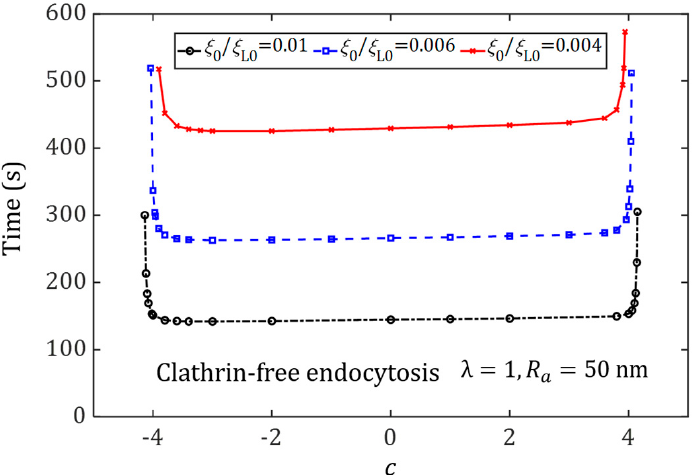
Figure 6. Wrapping time as a function of the degree of non-uniformity of ligand distribution, c , at different initial receptor density situations ξ 0 = 0.004 ξ L 0 , ξ 0 = 0.006 ξ L 0 and ξ 0 = 0.01 ξ L 0 , during the cellular uptake of spherical NPs ( R a = 50 nm, λ = 1) for the membrane-mediated endocytosis pathway.